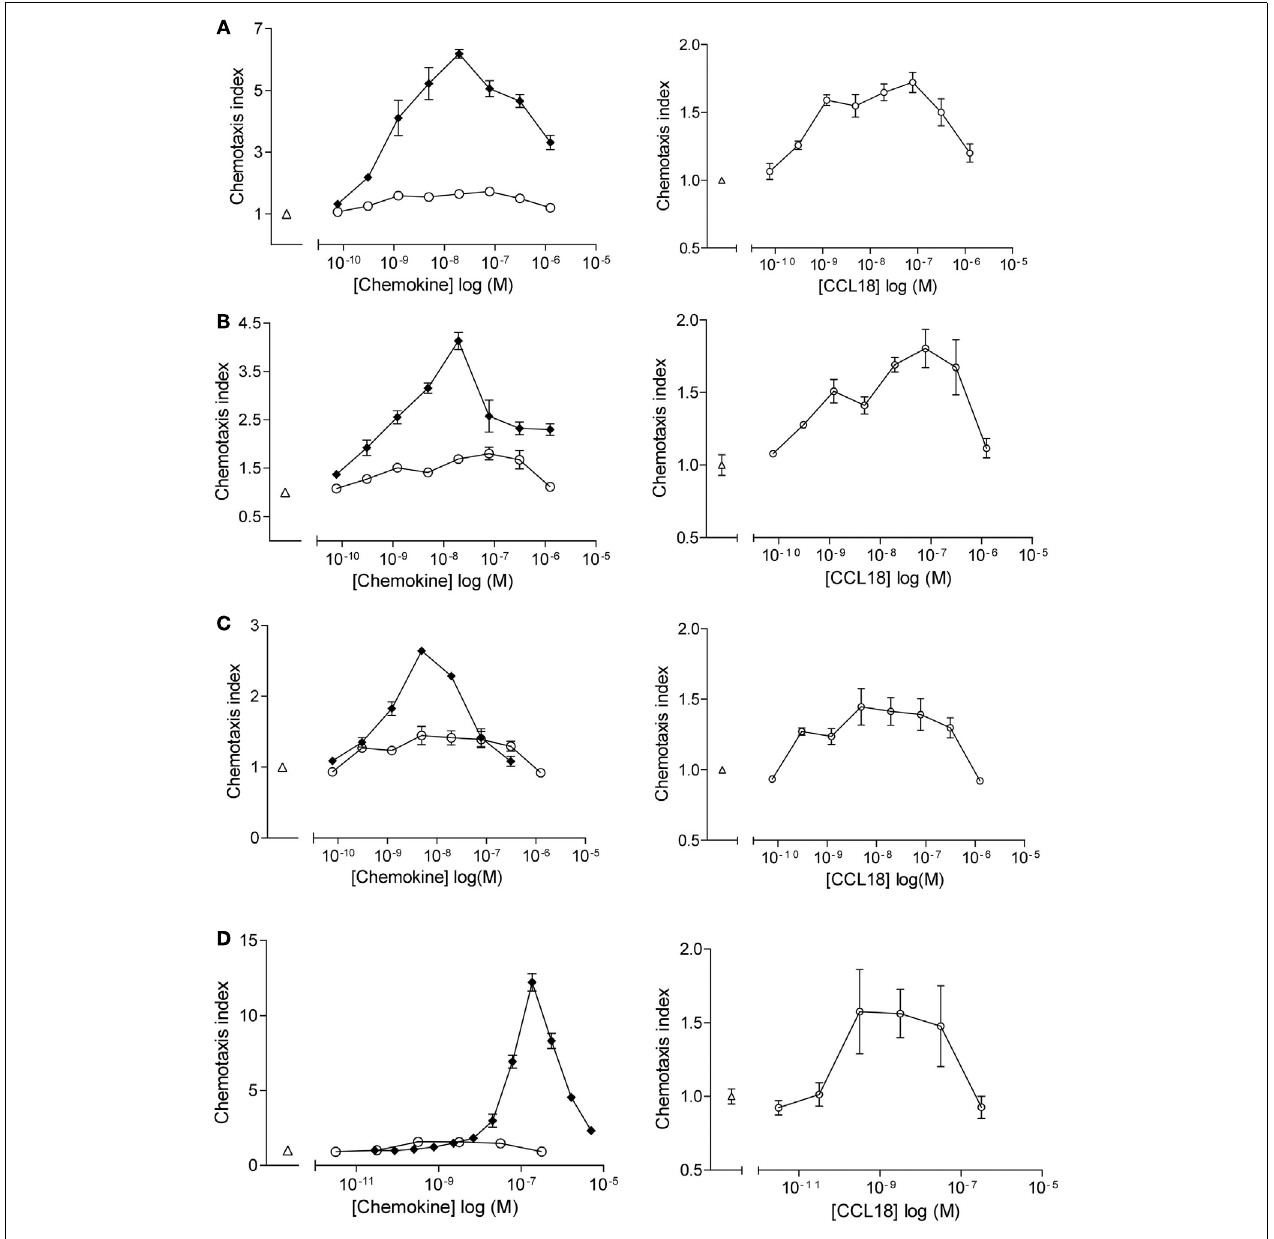
CXCL13. Medium was used as a control ( ∆ ). Increase in scale and exclusion of chemotactic response induced by the potent receptor agonists (right panel). Data are expressed as chemotaxis index ± SEM. Data points are in triplicate. One out of two independent experiments is